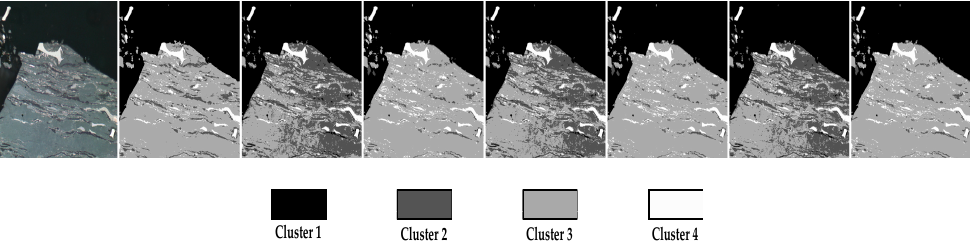
Figure 4. Comparison of automated segmentation results with ground truth. From left to right, the images represent original image, ground truth, the segmentation results of single-level Fuzzy c-means (FCM), 2-level FCM, single-level K-medoids, 2-level K-medoids, single-level K-means, and 2-level K-means.